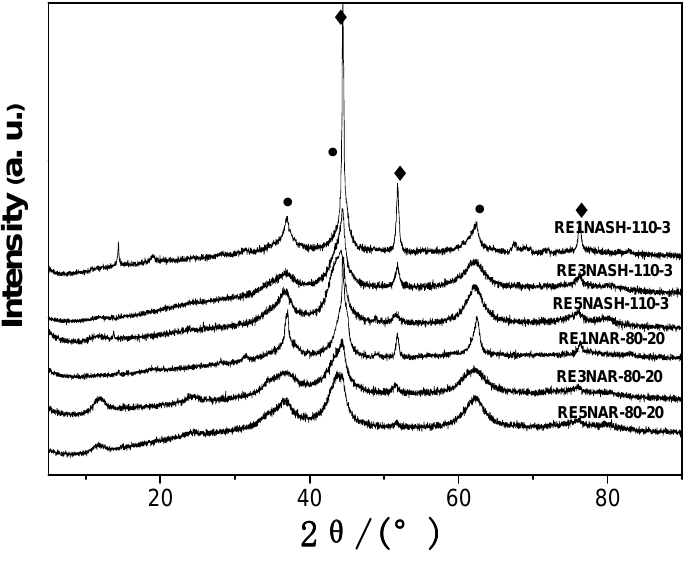
Figure 2. XRD patterns of Ni-based catalysts obtained from Ni/Al HTlcs: ● -NiO, ♦